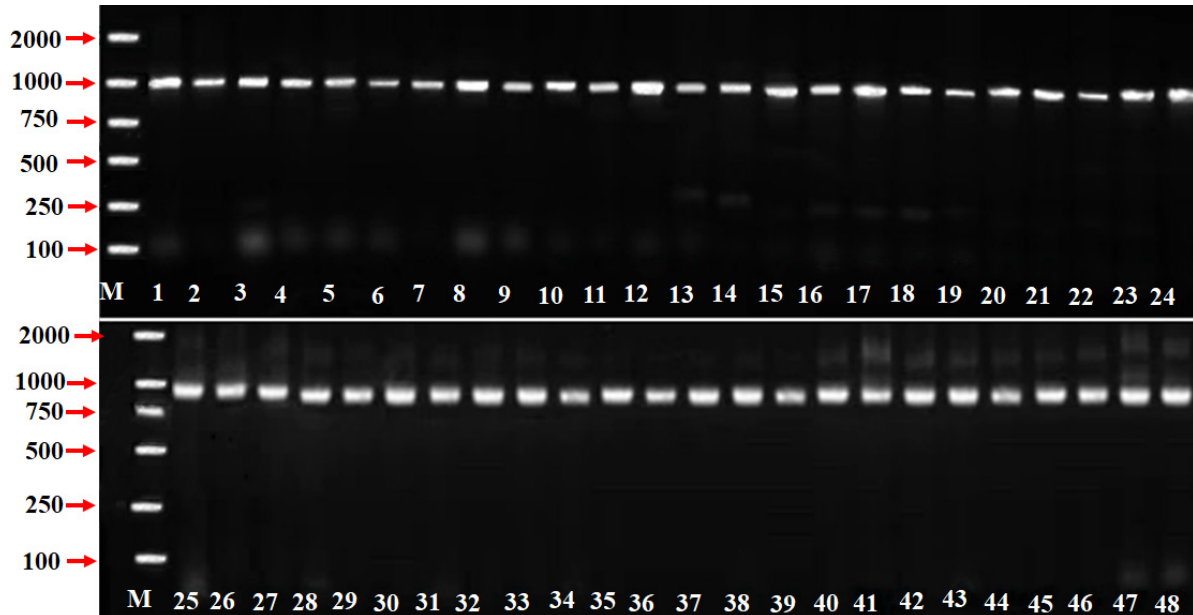
Figure 1. SFB alleles AS-PCR amplification in 48 P. mume accessions. Lane M = 2000 bp ladder marker, lane 1 to lane 48 represent the accessions in Table 1. Schemes follow the same formatting.